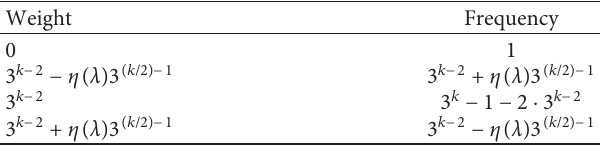
for Corollary 1 (i). S